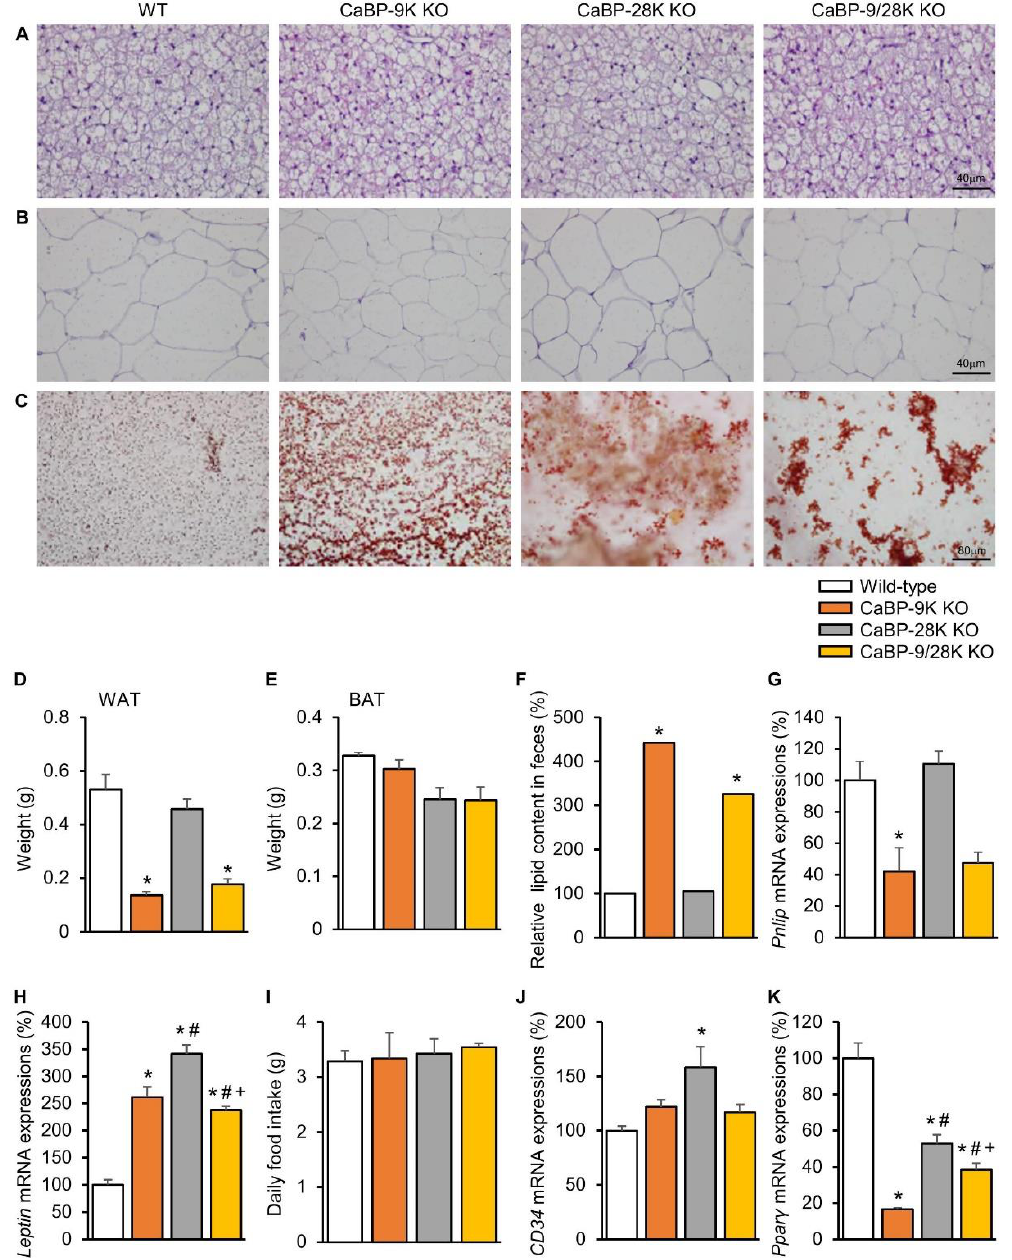
Figure 3. The e ff ects of CaBP-9k, 28k, and 9 / 28k ablation in lipid metabolism in adipose tissue. Lipid metabolism analysis with brown adipose tissue (BAT) ( A ) and white adipose tissue (WAT) ( B ) histology using H&E staining. Fecal lipid staining with Sudan III ( C ). Measurement of WAT ( D ) and BAT ( E ) weights for each group. Lipid contents in fecal quantification ( F ) and the expression of pancreatic lipase expression ( Pnlip ) in pancreatic tissue ( G ) were examined. Leptin ( H ), daily food intake ( I ), CD34 ( J ), and Ppar γ ( K ) regulate lipid deposition in adipose tissue. Values are expressed means ± SDs; * p < 0.05 versus WT; # p < 0.05 versus CaBP-9k KO; + p < 0.05 versus CaBP-28k KO. Scale bar, 40 µ m in ( A , B ); 80 µ m in ( C